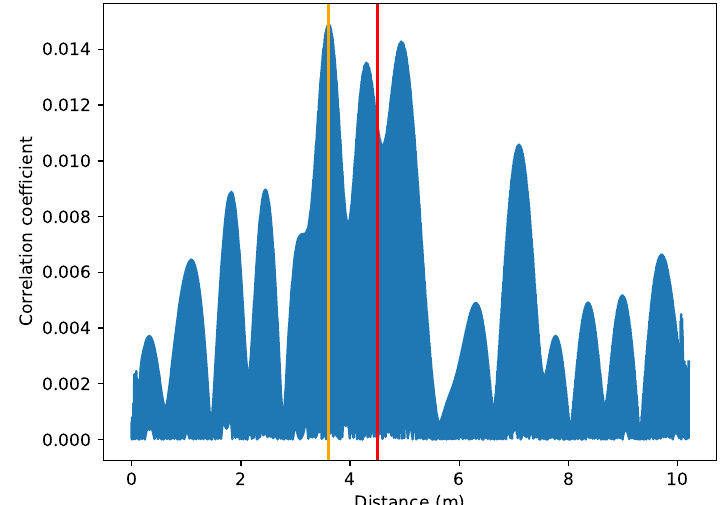
Figure 11. Example of a correlation plot between the received RF samples and the original transmitted chirp for an interdistance of ∆ x a = 5m. The red line is the actual distance, whilst the orange line is the selected maximum peak for the used distance estimation.